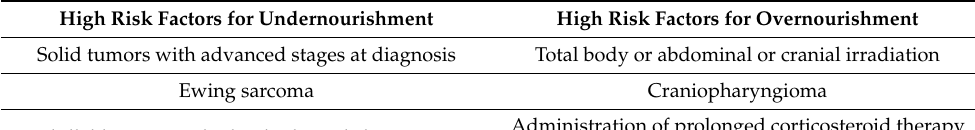
Table 2. Factors identifying a high risk for undernourishment and overnourishment. High Risk Factors for Undernourishment High Risk Factors for